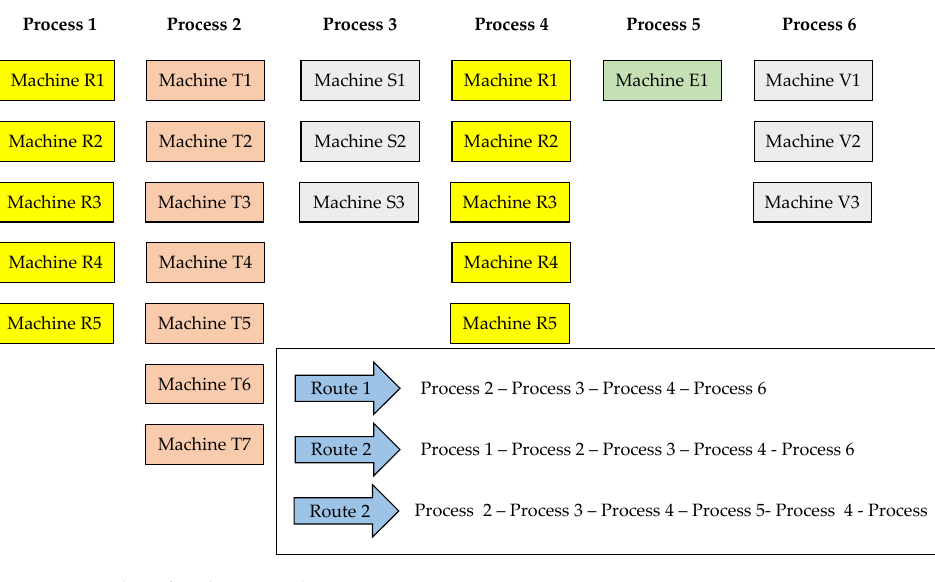
Figure 10. Fabric finishing production system. Table 1. Genetic algorithm parameter